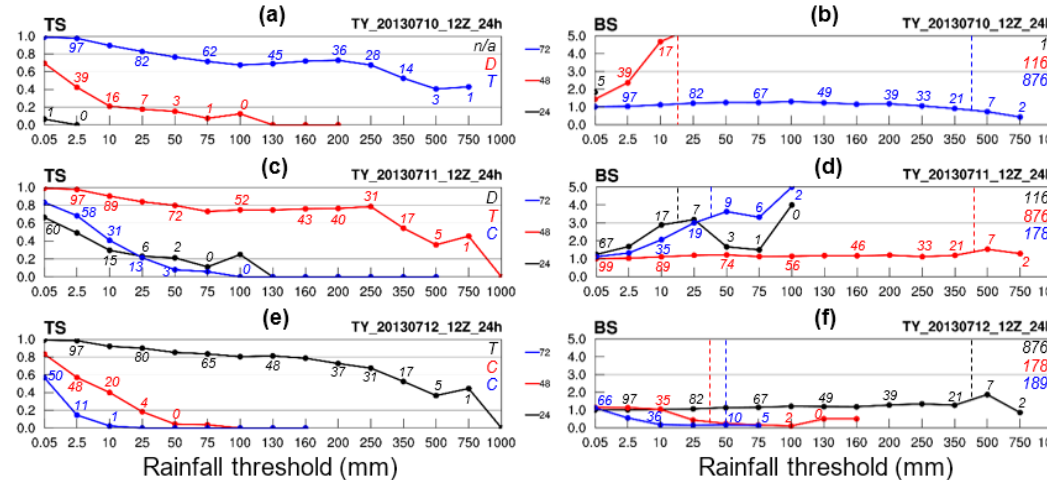
Figure 5. ( a ) TS and ( b ) BS of CReSS 24 h QPFs for day 1 (black), day 2 (red), and day 3 (blue) from the forecast made at 12:00 p.m. UTC 10 July 2013 as a function of threshold (mm). ( c , d ) and ( e , f ) As in ( a , b ), but from the forecasts made at 12:00 p.m. UTC 11 and 12 July 2013, respectively. The hit rate ( H / N ) and observed base rate ( O / N ) as percentages (%, rounded to integer) are labeled for selected points inside the panels for TS (left) and BS (right), where the base rate at 10% is marked (vertical dashed line). The classification group of T (for T10) or A–D (left, n/a for not available) and the observed maximum 24 h rainfall (right, mm, rounded to integer) are also given in the upper right corner inside the panels.